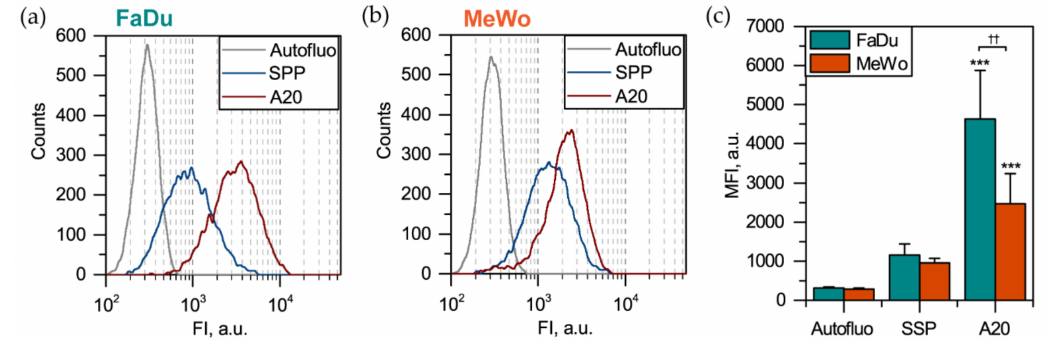
Figure 4. Uptake of QDs in 2D monolayer FaDu and MeWo cells. Typical cytometry distribution histograms of ( a ) FaDu and ( b ) MeWo monolayer cells 3 h post-incubation with 50 nM of QDs. ( c ) Mean fluorescenceintensity(MFI)ofFaDu(cyanbars)andMeWo(orangebars)cells3hpost-incubationwithQDs (n = 6–7; *** p < 0.001 compared to autofluorescence, using ANOVA; †† p < 0.01, using two-sample